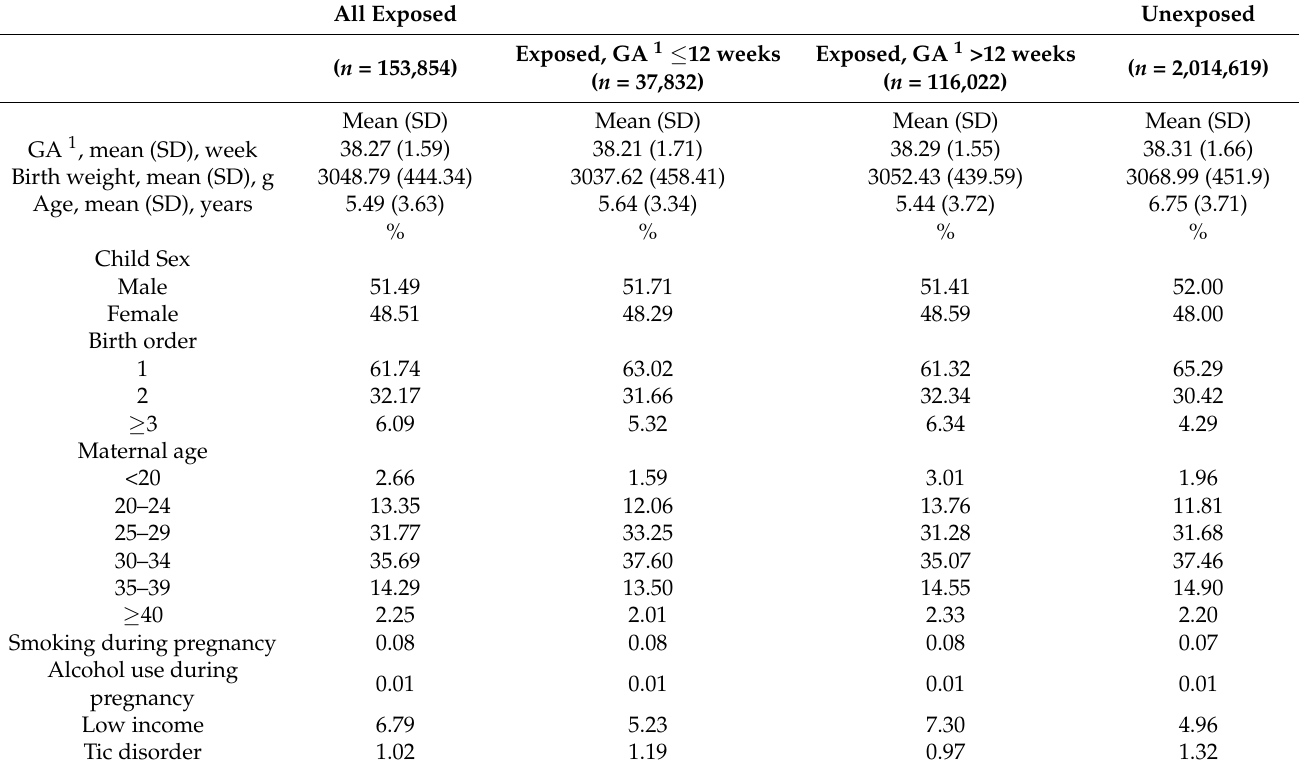
Table 1. Selected characteristics by maternal anemia exposure in the study cohort. All